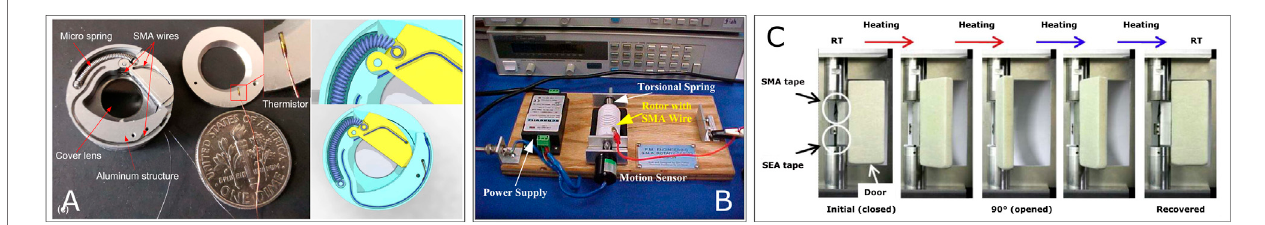
FIGURE 6 | Examples of BRM actuator using SMA wire element: (A) A mesoscale SMA actuator for cleaning the contaminated lenses of surgical cameras during minimally invasive robotic surgery (Liu et al., 2019); (B) A rotary servo driven by a coil form SMA wire, the shape “ re-set ” torque is provided by a torsional spring (Song, 2007); (C) An opening and closing door device capable of a two-way rotary motions using a combination of a SMA and SEA (superelastic alloy). The strip was biased passively by a PE element for position resetting (Tobushi et al., 2013).